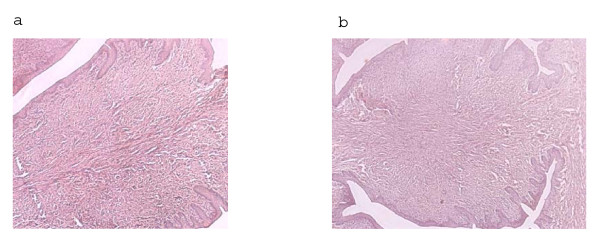
Light microscopic images of CAD treated rat vaginal sections. (a) K-Y jelly based control; (b) 82 mg/ml CAD. Compared to the intact vaginal cell lining in the control sections (a), there were inflammatory changes in the epithelial cell lining of the treated tissue (b). Original magnification × 200.